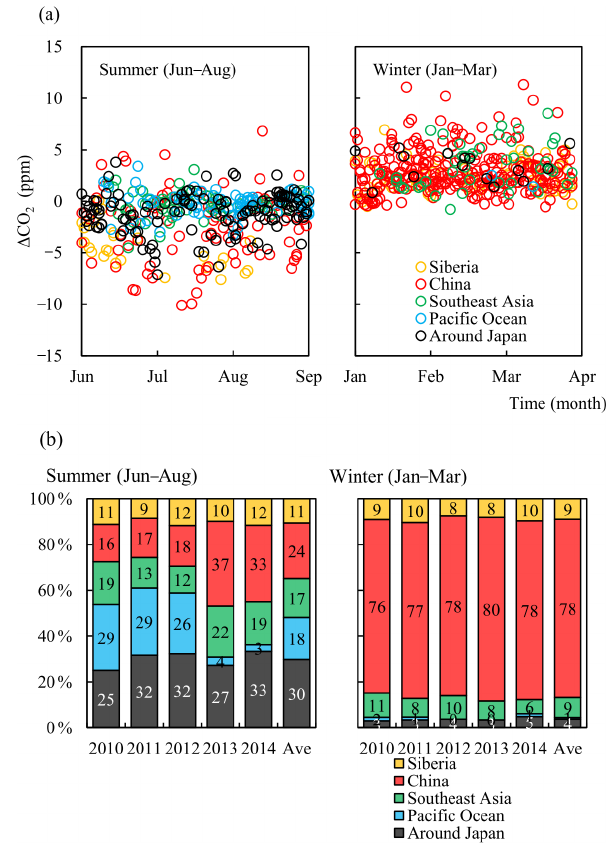
Figure 11. (a) Differences between daily CO 2 concentration in summer (June–August) and winter (January–March) at Mt. Fuji and Mauna Loa Observatory for five areas of air mass origin (Fig. 1), and (b) percentage of air mass origin in summer (June–August) and winter (January–March) at Mt. Fuji from 2010 to